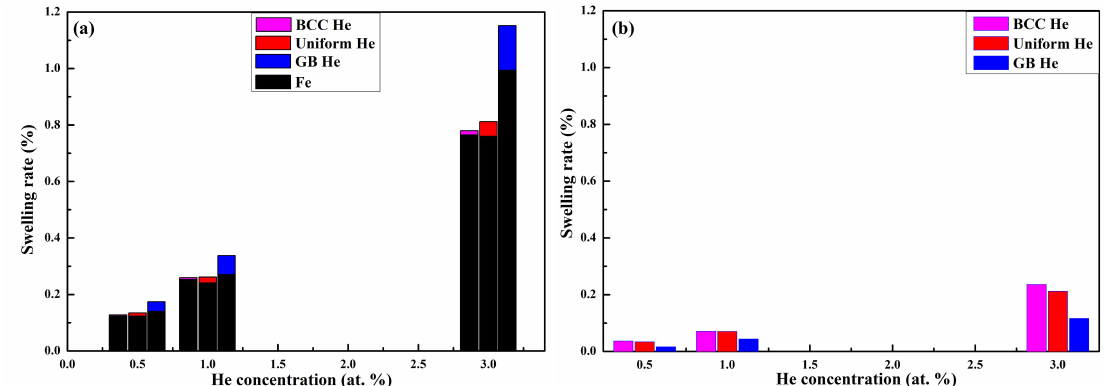
Figure 5. The swelling rate of nanocrystalline models are plotted as a function of He concentration. ( a ) The swelling rate is calculated by the expansion of atomic volume. The swelling rate contributed by Fe is represented by black bar. The swelling contributed by the expansion of He was colored according to the distribution of He in the models; ( b ) The swelling rate is contributed by the expansion of lattice site, the color of the bar represent the distribution of